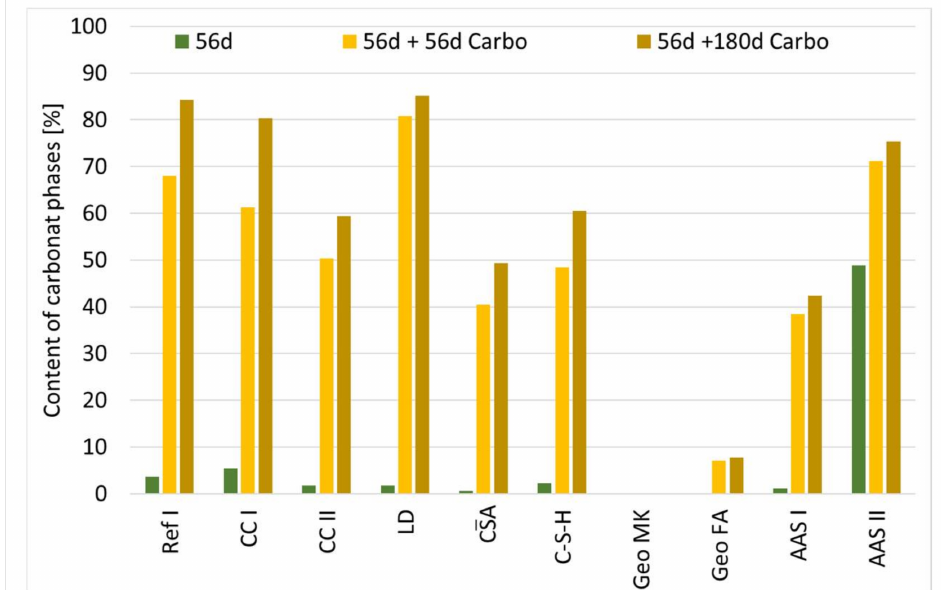
Figure 4. Carbonate phase content during carbonation of cement paste